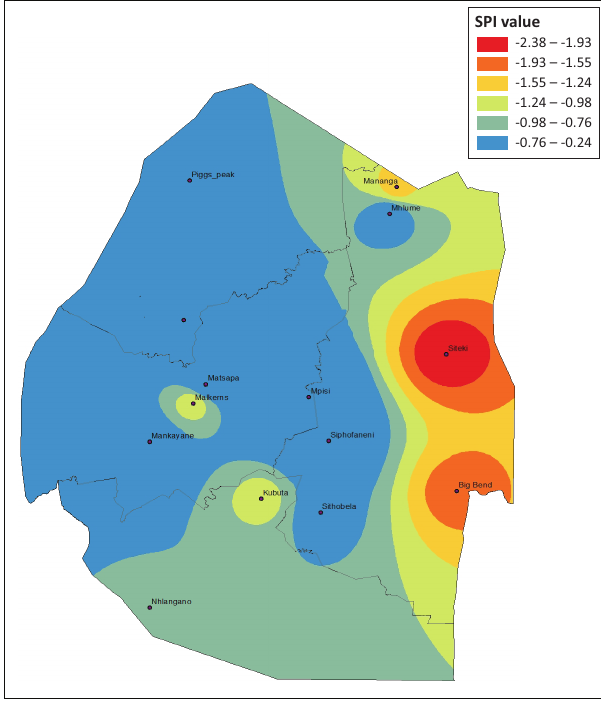
FIGURE 5: Three-month Standard Precipitation Index values for the Highveld, Middleveld, Lowveld and Lubombo Plateau agro-ecological